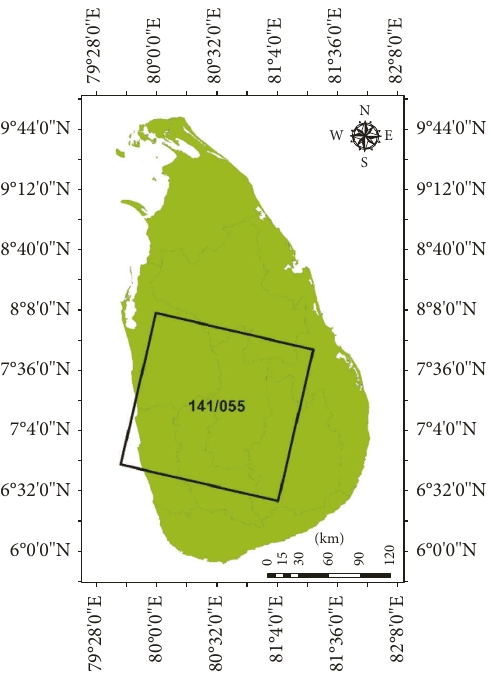
Figure 2: Landsat tile arrangement of